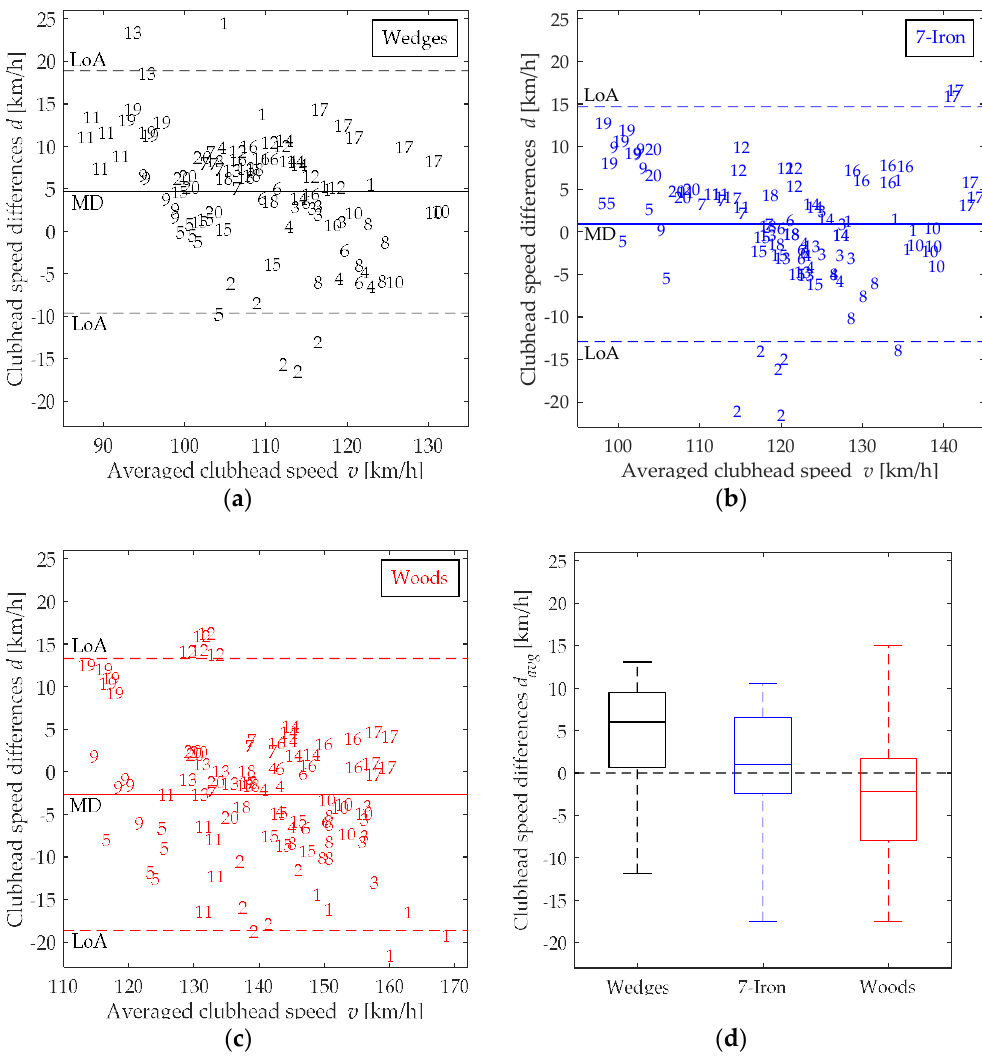
Figure 1. ( a – c ) Bland-Altman-diagrams showing measurement error d vs. clubhead speed (cid:1874) , averaged via Trackman 4 and Zepp Golf 2. The 5 swings per subject are denoted as subject numbers (1 to 20). MD and LoA are represented by solid and dashed lines, respectively. Corresponding values, including correlation coefficients, are noted in Table 1. ( d ) Box plots show the distribution of subject- averaged measurement errors (cid:1856) (cid:3028)(cid:3049)(cid:3034) , grouped by the different club types. The dashed line suggests a measurement error of